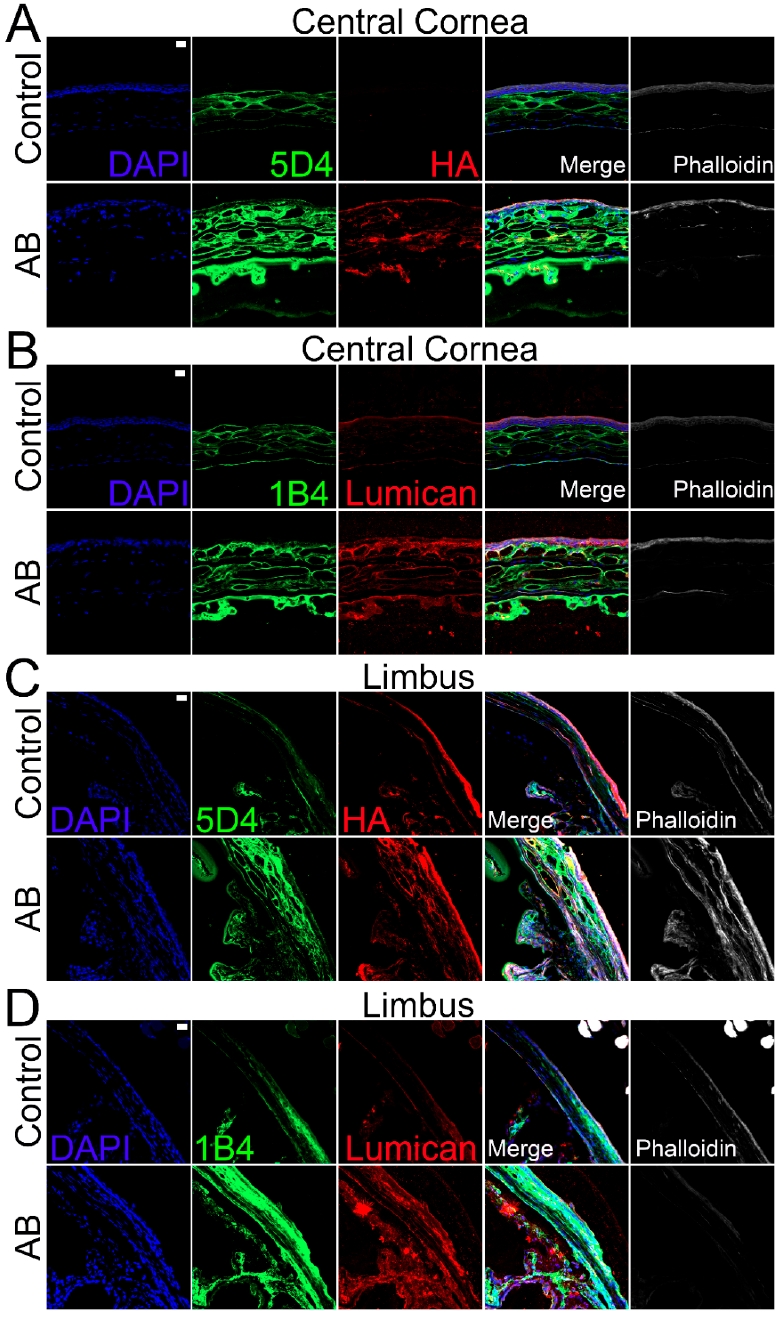
Figure 7. Expression and localization of different KS epitopes, HA and lumican in the central corneal and limbal region of mice before and after AB. Mouse corneas were subjected to AB and corneas analyzed after 14 days, with contralateral corneas used as controls. The central cornea ( A , B ) and the limbal region ( C , D ) were imaged under a confocal microscope. The expression and localization of highly sulfated KS (5D4) and HA were analyzed using immunocytochemistry ( A , C ). The expression and localization of lesser sulfated KS (1B4) and lumican were analyzed using immunocytochemistry ( B , D ). Nuclei were stained with DAPI (blue). Scale bar 20 μ m. Seven corneas were analyzed per experimental point and a representative image displayed.